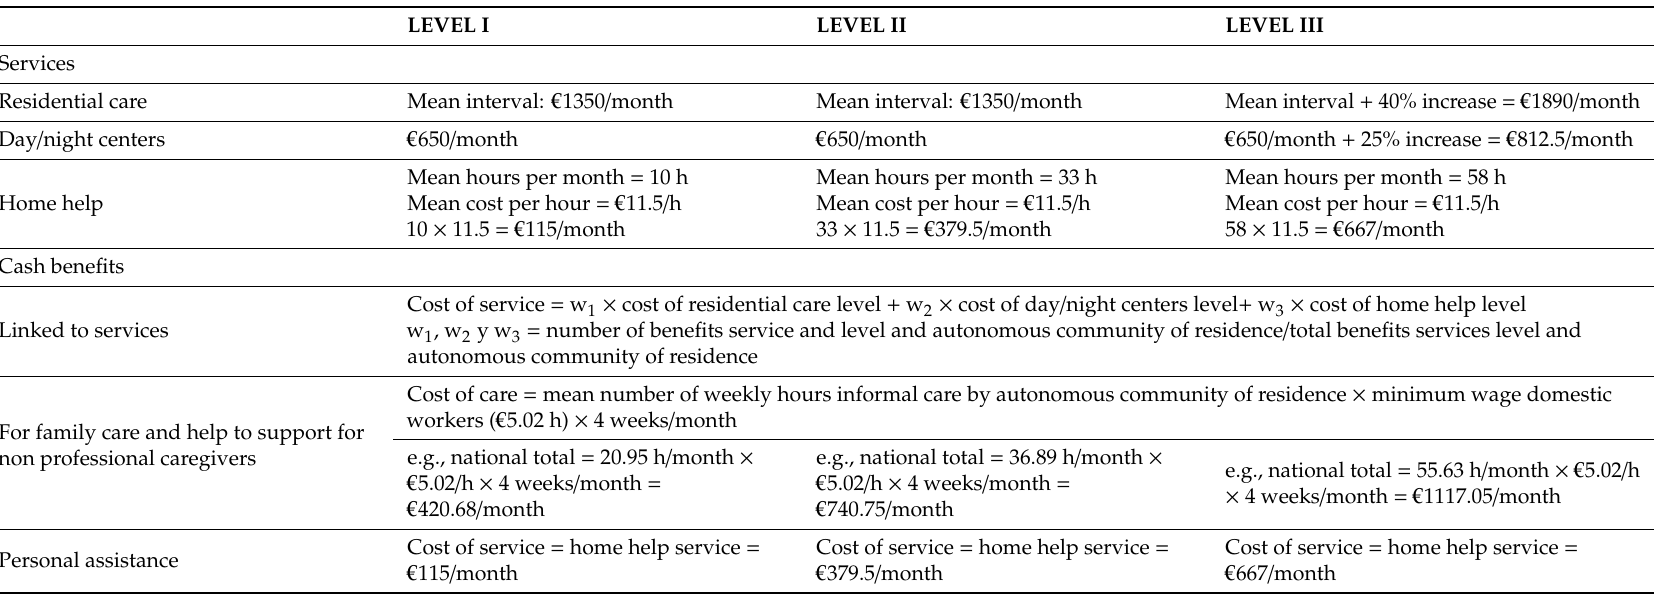
Table 2. Cost of dependent care benefit by type in euros,